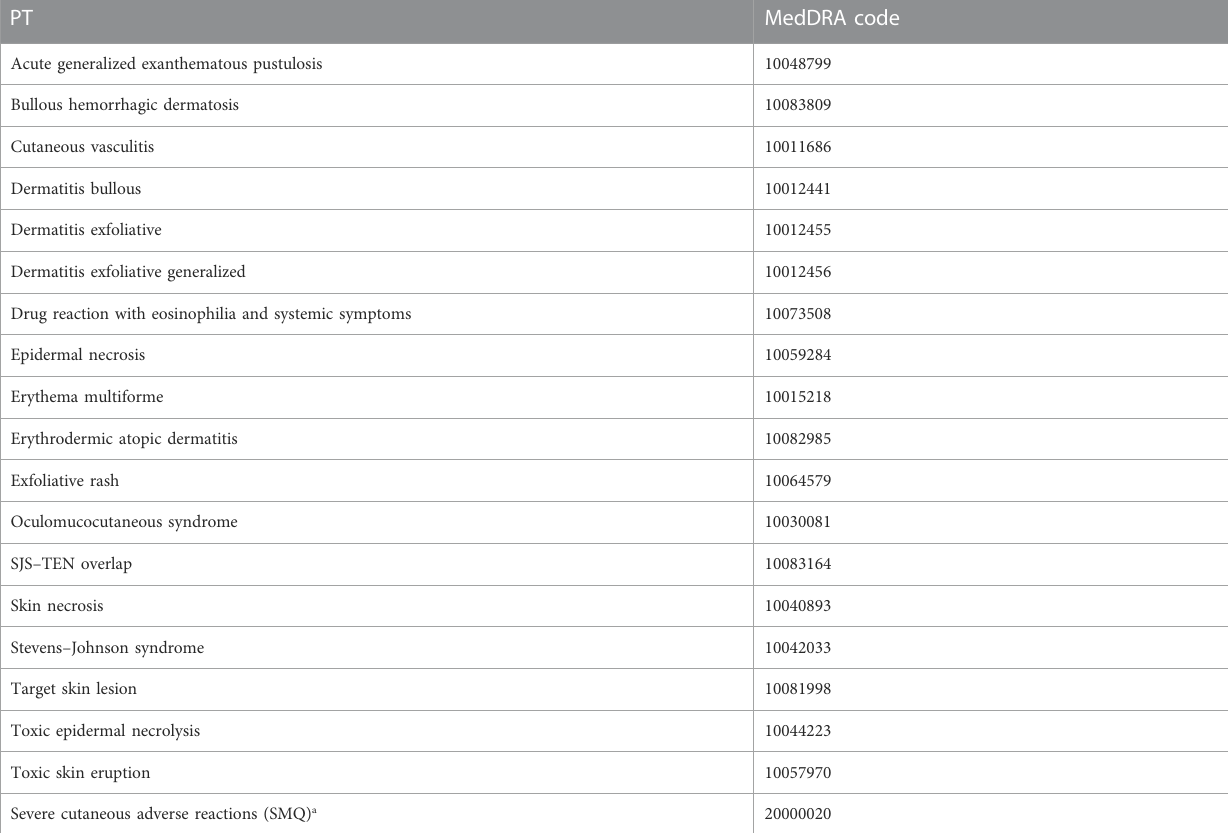
TABLE 1 Eighteen narrow-scope PTs in SMQ classi fi cation of SCARs.